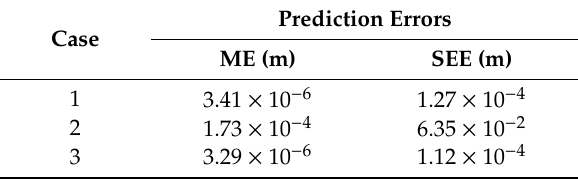
Table 9. The prediction errors for three cases. ME: mean error; SEE: standard error of the